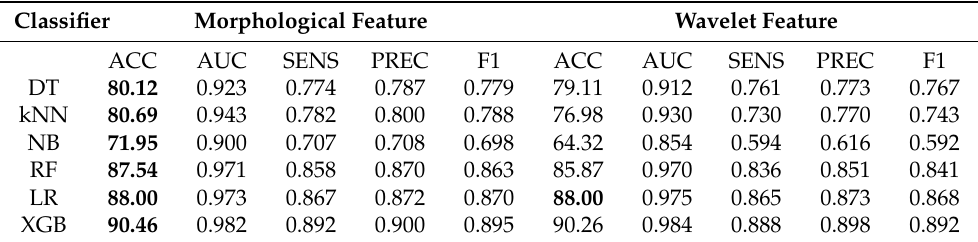
Table 5. Comparison of performance between the morphological feature and the wavelet feature. ACC, accuracy; SENS, sensitivity; PREC, precision; F1,